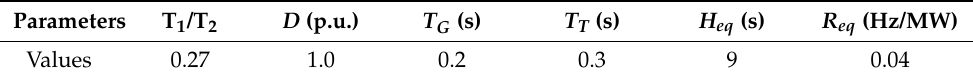
Table 4. Initial values of the parameters for the primary frequency response simulation of the power system